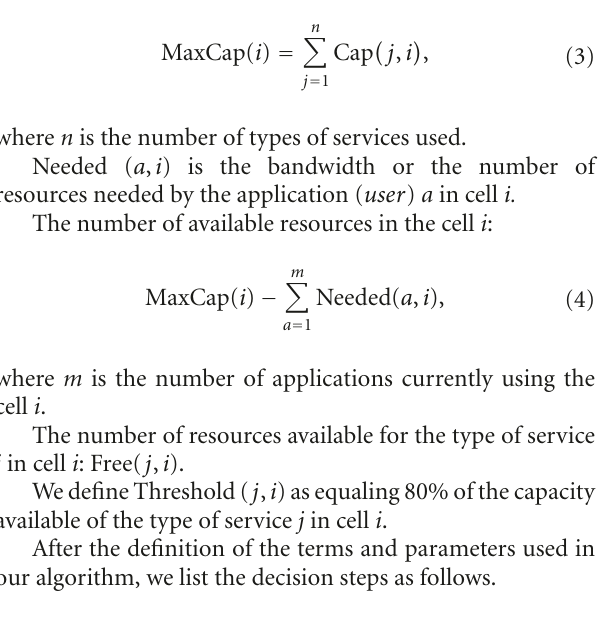
Algorithm 6. Multi-Constraint Dynamic Access Selection